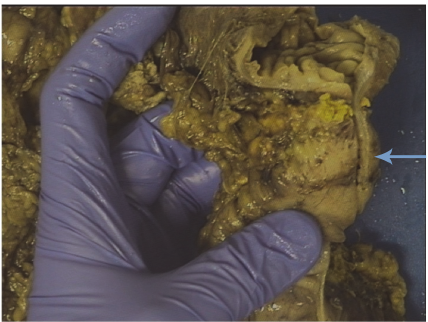
Figure 4: Segment of resected colon with the arrow showing the site of